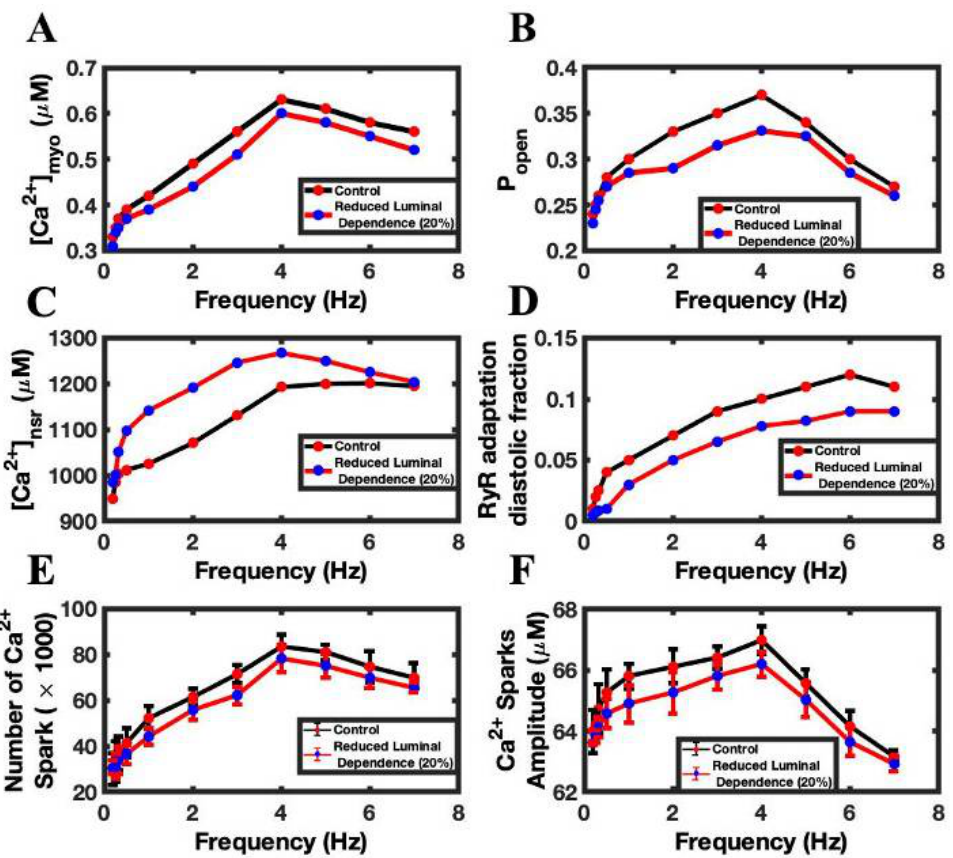
Figure 7. The effect of reduce luminal dependence of RyR2 open probability on frequency-dependent behaviors. ( A ) Peak myoplasmic Ca 2+ concentration. ( B ) RyR2 open probability. ( C ) Peak NSR Ca 2+ concentration. ( D ) Diastolic fraction of RyR2 in the adapted state. ( E ) Number of Ca 2+ sparks. ( F ) Ca 2+ spark amplitude. Control simulations are shown in black. Simulations with reduced luminal dependence are shown in red.